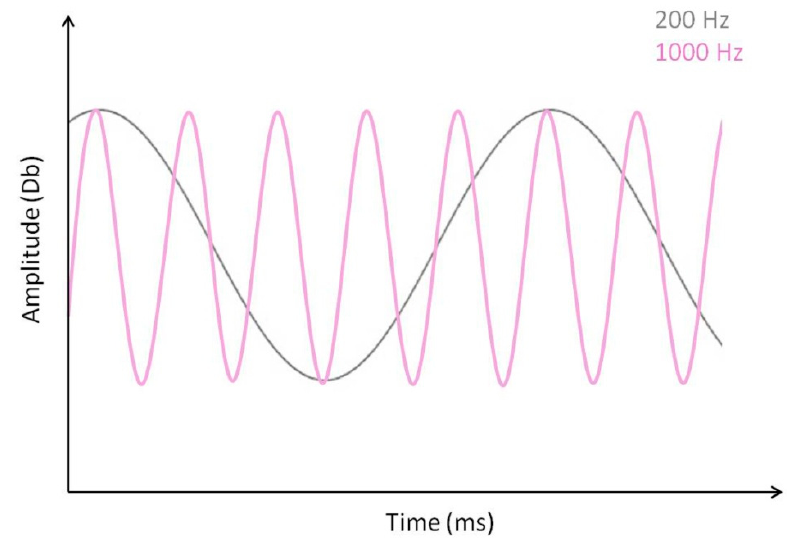
Figure 2. Illustration of a 200 Hz and a 1000 Hz sound wave of identical amplitude (Db). Within the audible frequency range (20 to 20,000 Hz) for humans, higher-frequency (higher pitch) sounds of a given amplitude are perceived as “sharper” than lower-frequency sounds of identical amplitude.